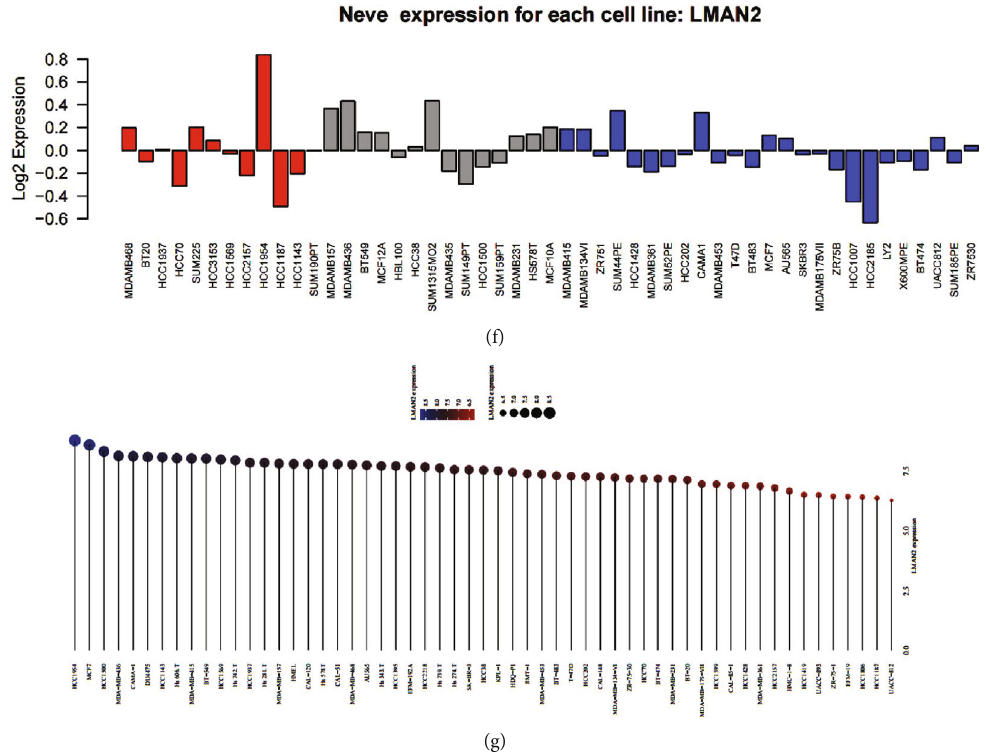
Figure 2: The association between LMAN2 expression and clinicopathological characteristics. (a) The LMAN2 mRNA expression in breast cancer by UALCAN. LMAN2 expression was linked to clinicopathologic characteristics, such as clinical stage, race, sex, p53 mutation status, age, cancer subclasses, distant metastases, and menopause. (b) Analysis of LMAN2 expression in breast cancer using the bc-GenExMiner v4.7 database. Di ff erential expression of LMAN2 in patients with ER-negative and ER-positive, HER2-negative and HER2-positive, lymph node metastasis-positive and lymph node metastasis-negative, p53 mutation-positive and p53 mutation-negative, nontriple negative breast cancer (non-TNBC) and TNBC, nonbasal-like and basal-like, NPI1 vs. NPI2 vs. NPI3, SBR1 vs. SBR2 vs. SBR3, IDC vs. ILC vs. IDC/ILC vs. “ mucinous ” vs. micropapillary, luminal A vs. HER2-positive vs. luminal B vs. basal-like, and ER-positive/PR-positive vs. ER-negative/PR-positive vs. ER-negative/PR-negative vs. ER-positive/PR-negative breast cancer patients using bc-GenExMiner v4.7. (c) The protein expression of LMAN2 in several subtypes of breast cancer patients as examined with the help of the UALCAN database. Association of LMAN2 expression with clinicopathological characteristics, including clinical stage, race, age, cancer subclasses, histological type, and cancer status. (d) Spatial transcriptomics assessment of gene expression in tissue sections. This work produced high-quality RNA-sequencing data on human breast cancer by importing histologic sections on arrayed reverse transcriptional primers with unique positional barcodes. The data included maintained two-dimensional position data from the histological sections. (e) The protein expression of LMAN2 in breast tumor and normal samples (HPA). (f) The LMAN2 expression in di ff erent breast cancer cells by GOBO. (g) The expression of LMAN2 in di ff erent breast cancer cells by CCLE and the expression distribution of LMAN2 in di ff erent cell lines. The gene expression is shown by the horizontal axis in the fi gure. The distinct cell lines are represented by the ordinate. The expression level is shown by the dot size and the various colors used in the illustration ( ∗∗∗ p ≤ 0 : 001 ; ∗∗ p ≤ 0 : 01 ; ∗ p ≤ 0 : 05